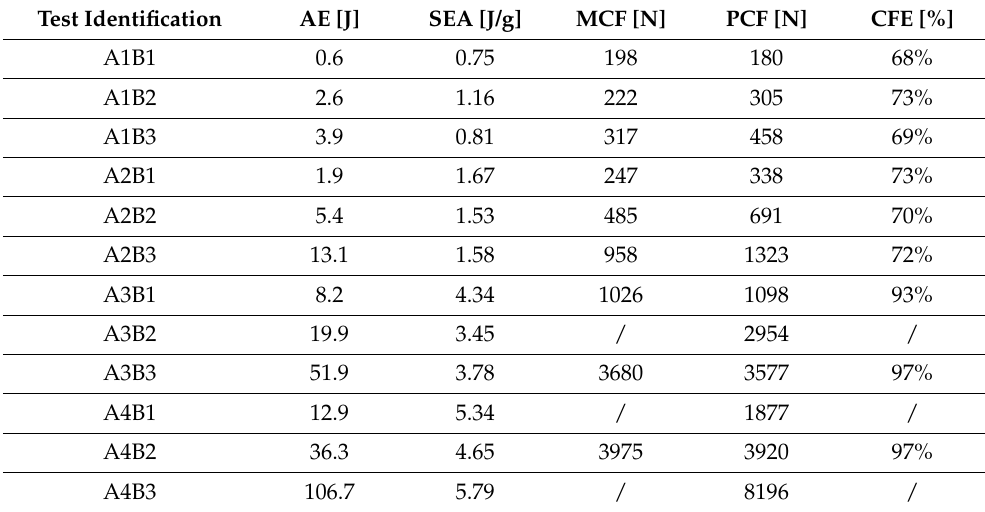
Table 5. Results of the FP2 : Comparison of the absorbing capabilities of the investigated specimens.